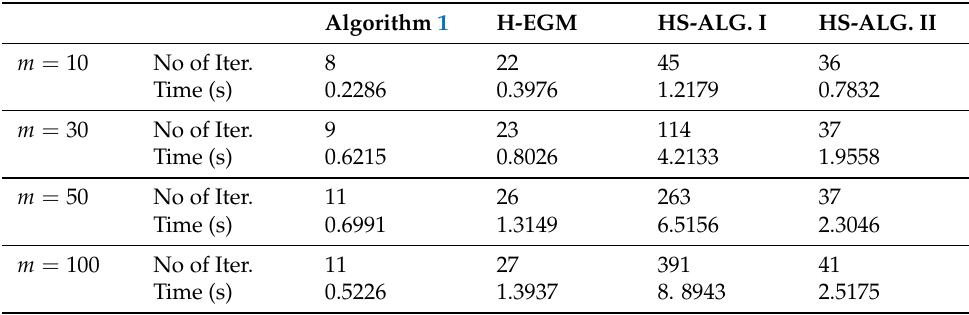
Table 1. Computational result for Example